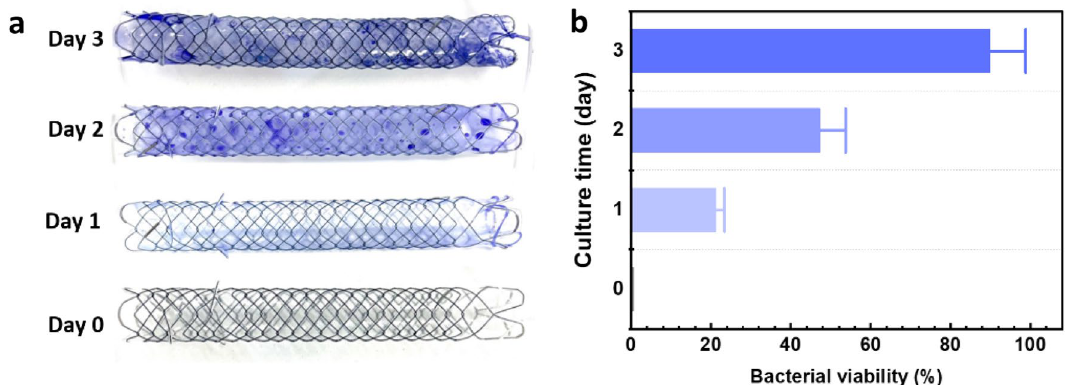
Figure 1. Growth of bacterial biofilm: ( a ) urethral stents stained with crystal violet at various time points after culturing and ( b ) bacterial viability versus culture